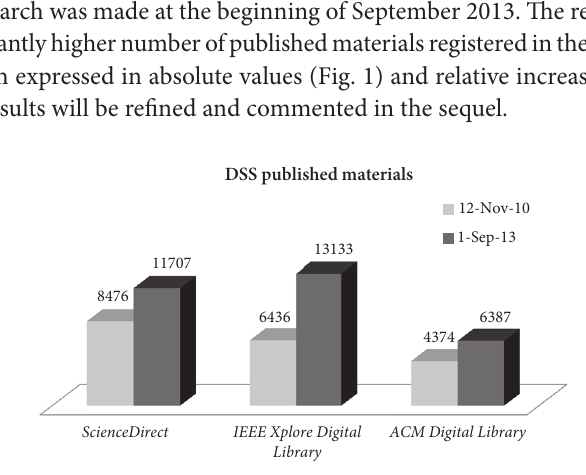
Fig. 1. Numbers of DSS materials in ScienceDirect, IEEE and ACM on the 12th of November 2010 and the 1st of September